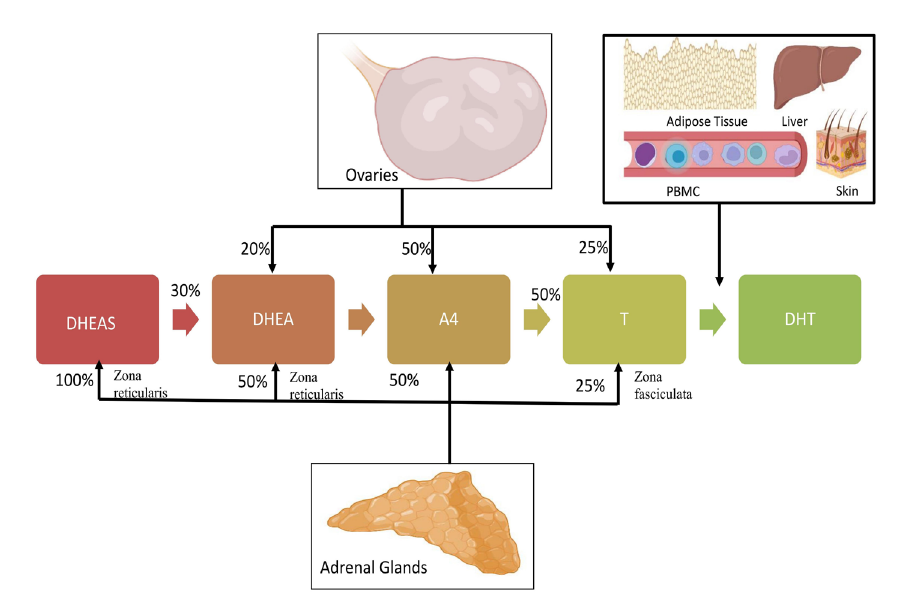
Figure 2. Relative contribution of adrenals and ovaries in circulating androgens in the female system